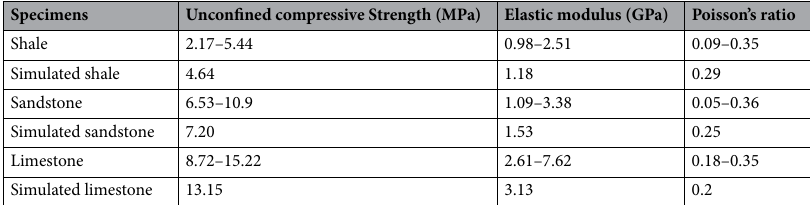
Table 1. Main mechanical parameters of rock-like materials and real rocks 29 .